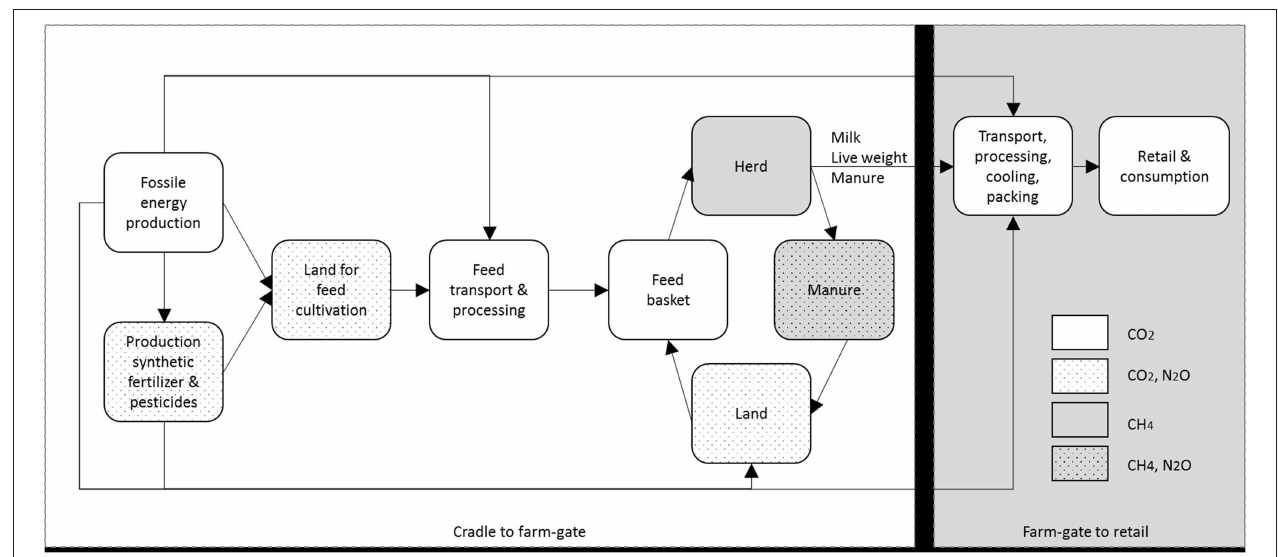
FIGURE 1 | Cradle to farm-gate system boundaries (indicated by the white rectangle) used for the analysis of greenhouse gas emissions.